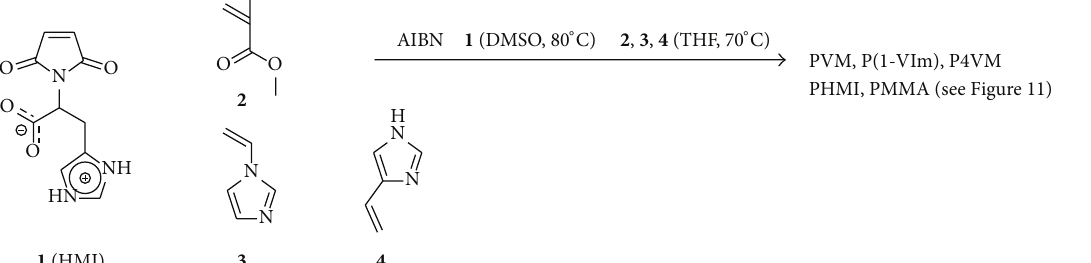
Scheme 8: Imidazole functionalization of polymers and monomers [48, 49] and monomers used for AIBN initiated radical polymerization [39, 47,